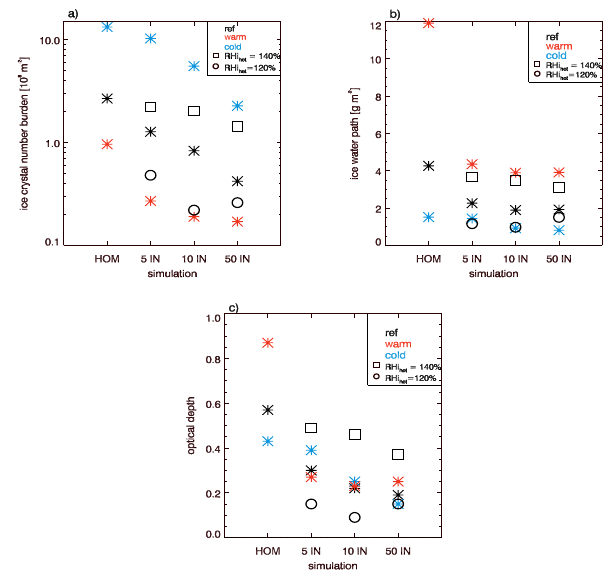
Figure 7. Averaged ice crystal number burden (a) , ice water path (b) and optical depth (c) for the simulations HOM, 5 IN, 10 IN and Fig. 7. Averaged ice crystal number burden (a), ice water path (b) and optical depth (c) for the simulations 50 IN. Black, red and blue asterisks show the results for the refer- HOM, 5IN, 10 IN and 50IN. Black, red and blue asterisks show the results for the reference, warm and ence, warm and cold temperature profiles for the simulation where cold temperature profiles for the simulation where the IN freeze at a critical supersaturation of 130 % . the IN freeze at a critical supersaturation of 130%. Additionally, Additionally, the results where RHi het is increased to 140 % (black square) or decreased to 120 % (black circles) are shown for the reference temperature profile. For the calculation of the mean, only values the results where RHi het is increased to 140% (black squares) or where τ > 0 . 03 are considered. 39 decreased to 120% (black circles) are shown for the reference tem- perature profile. For the calculation of the mean, only values where τ > 0 . 03 are